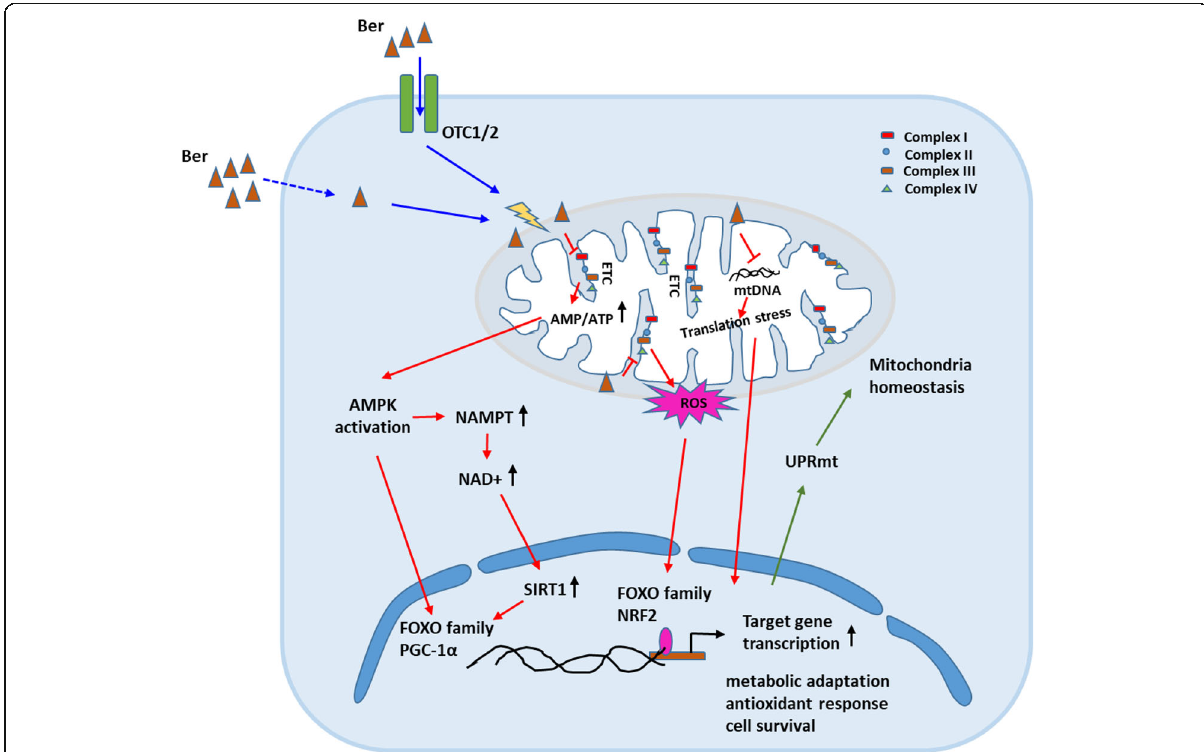
Fig. 1 Overview of Ber-mediated mitohormesis signaling. Ber mainly accumulated in the mitochondria after entering cells through organic cation transporter (OTC1/2) or passive diffusion. In mitochondria, Ber could target enzymes and other proteins associated with the electron transfer chain or mtDNA to disrupt energy homeostasis and induce translation stress. This can induce mitohormetic response via (1) ROS-mediated redox pathway, (2) AMP/ATP-induced AMPK pathway, (3) NAD+/NADH-mediated Sirtuins pathway (i.e., SIRT1), and (4) UPRmt pathway to regulate and maintain mitochondria homeostasis for the ability of cells to adapt to adverse